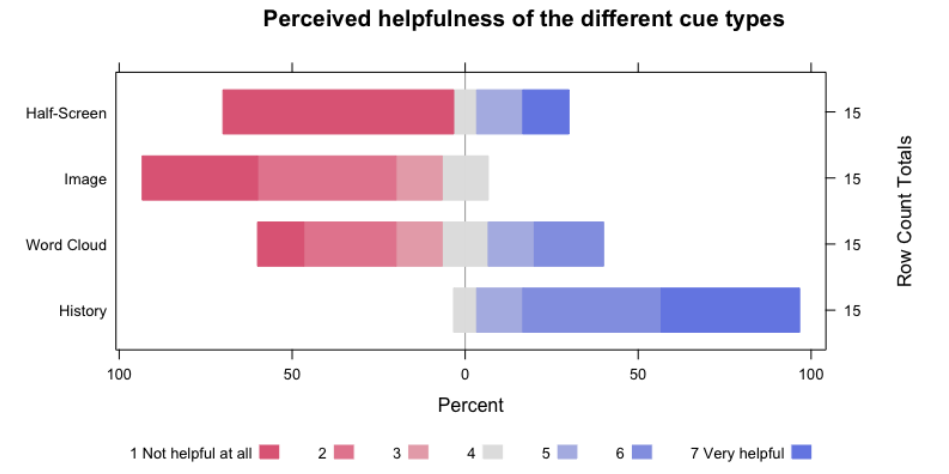
Figure 4. Perceived helpfulness of the different cue